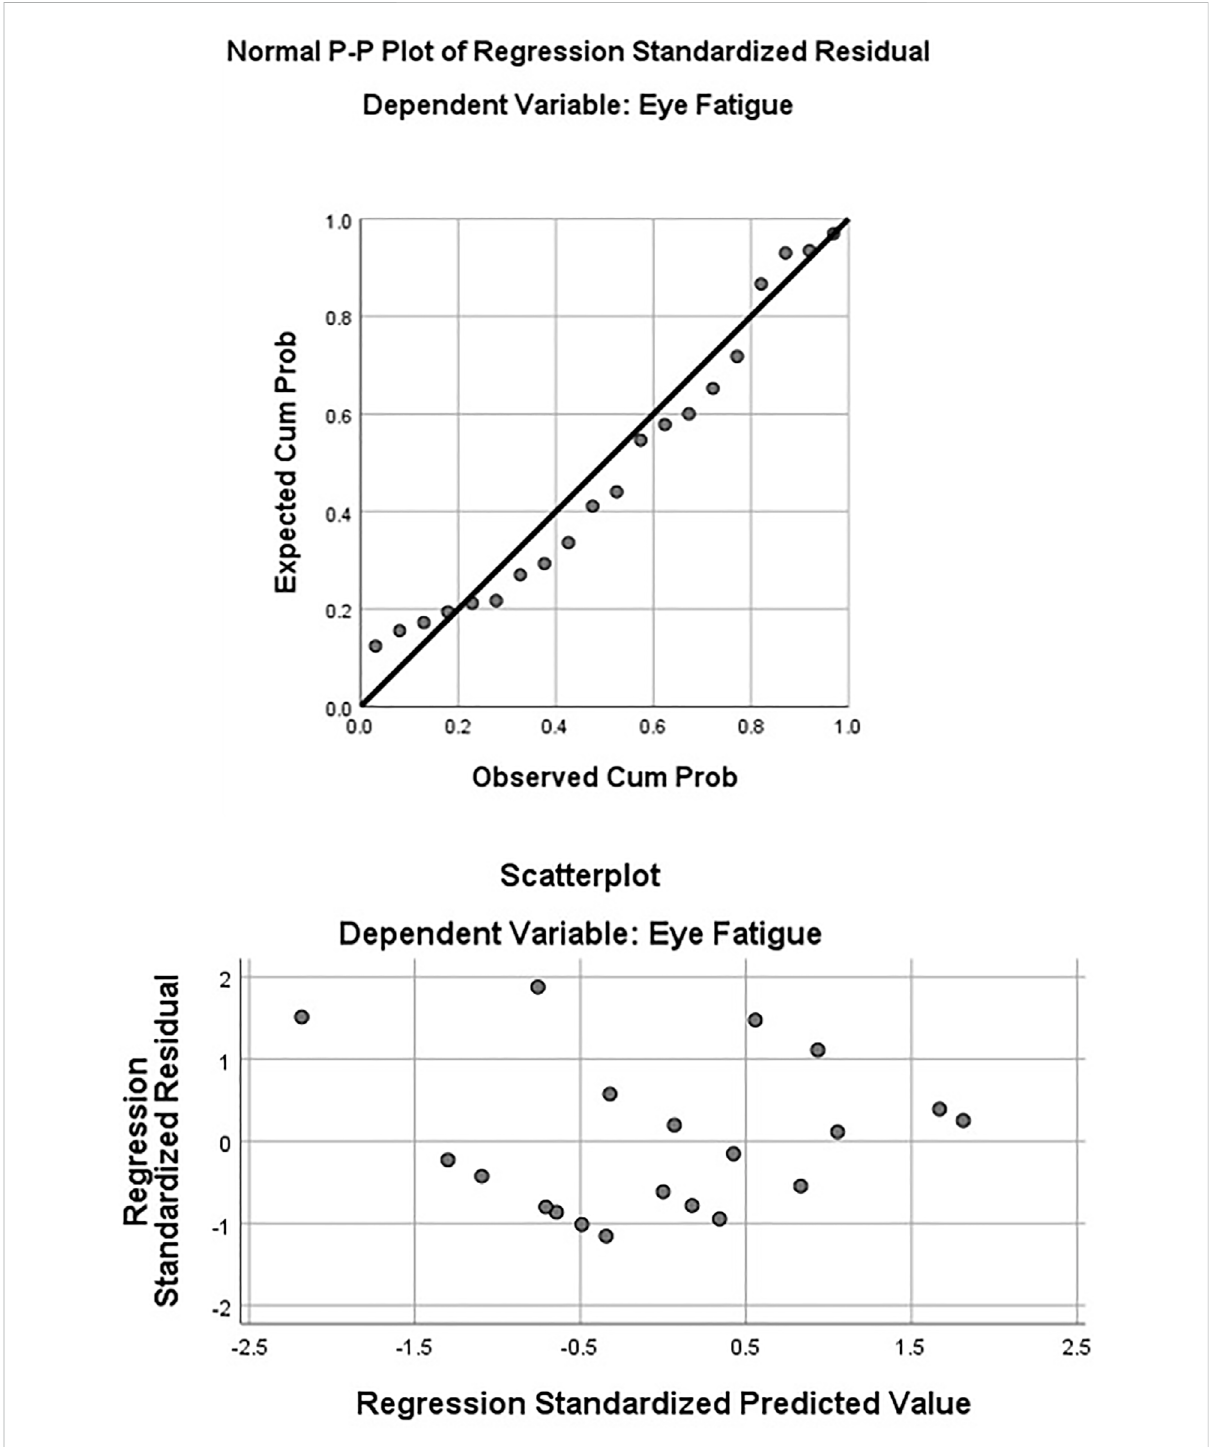
FIGURE 4 Diagnostic plots; eye